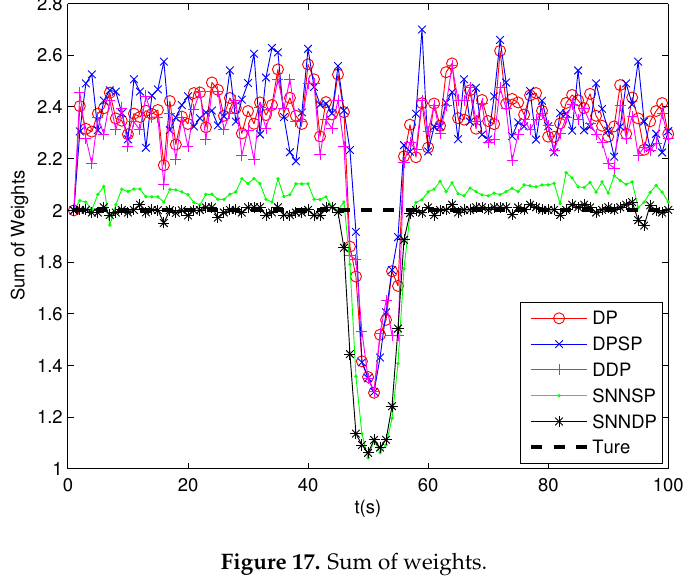
Figure 17. Sum of weights.